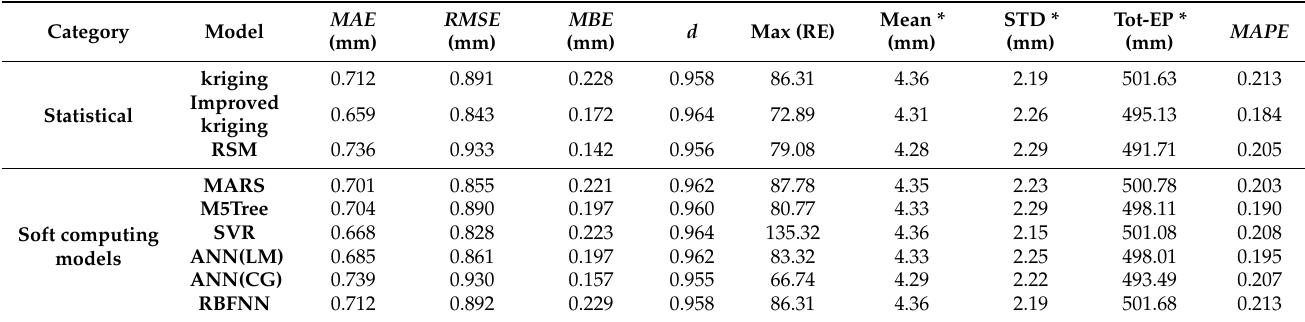
Table 1. Comparing the results of the applied models without periodicity (Scenario #1) for Adana station in the testing period.